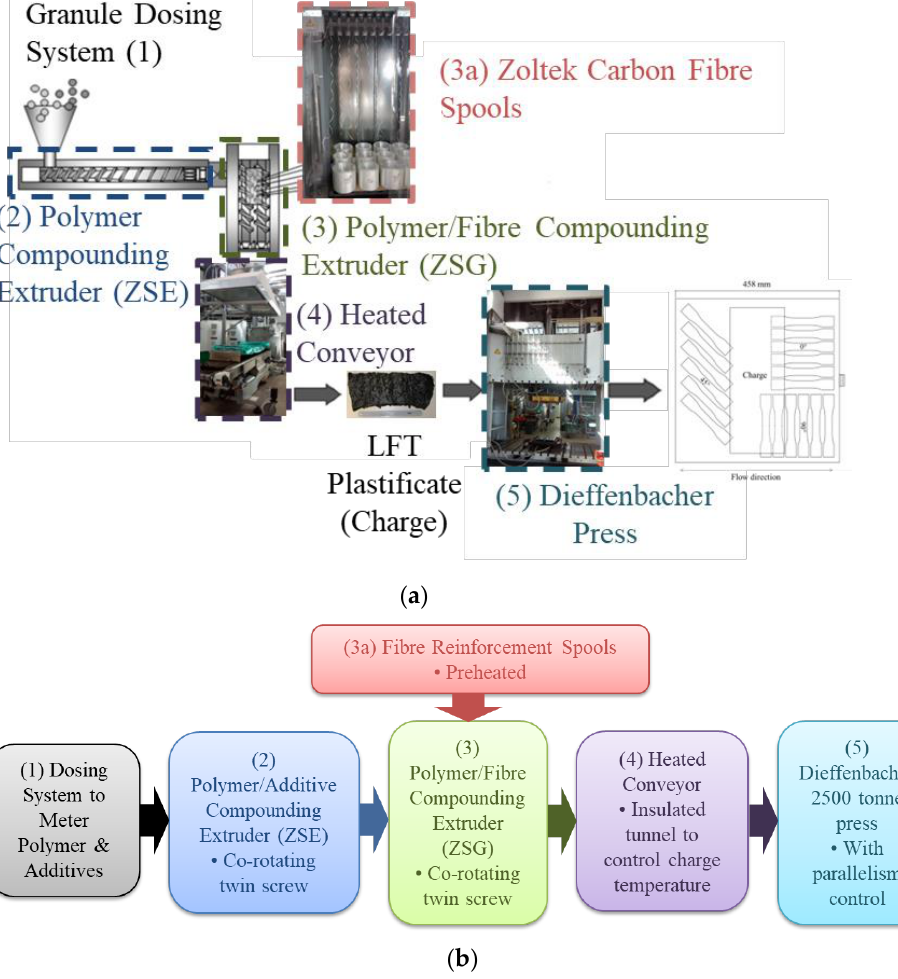
Figure 1. ( a ) Schematic and ( b ) Flowchart of Dieffenbacher DLFT line at the Fraunhofer Innovation Platform for Composites Research at Western University [11]. Table 3. Tool temperature set points and measurements.